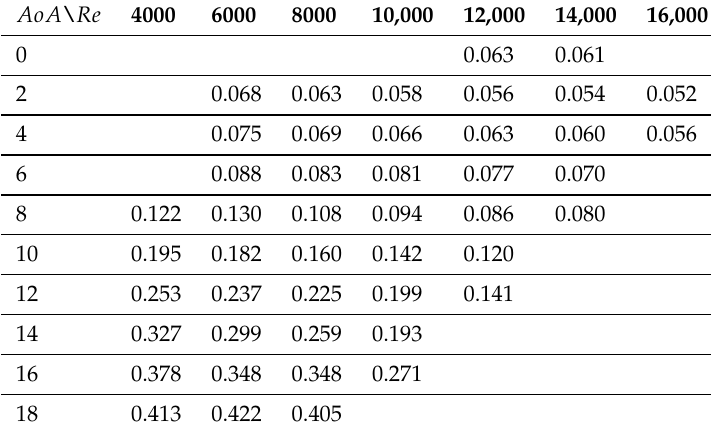
Table 9. Drag coefficient C D for the Reynolds numbers Re and the angles of attack AoA experienced by the blade sections for the tip-speed ratios around the optimal